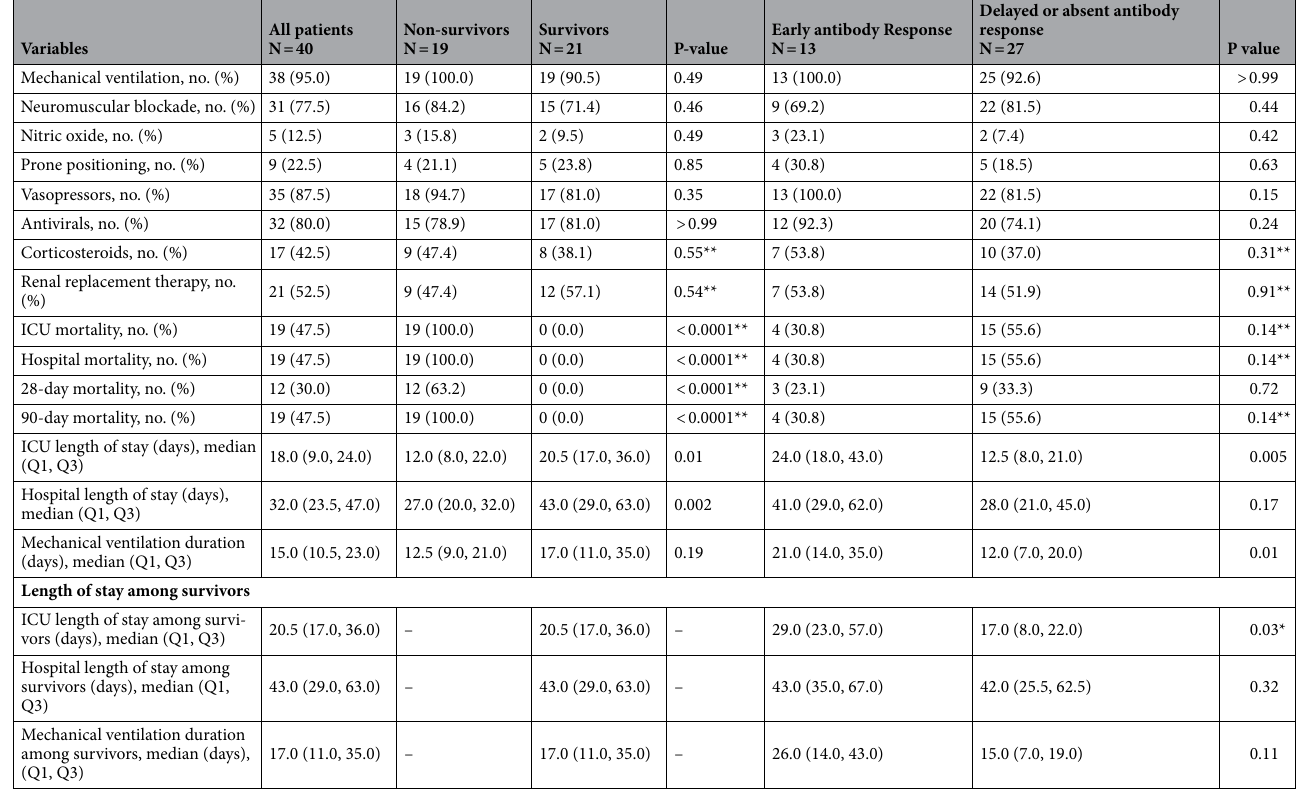
Table 2. Main interventions and outcomes of patients with Middle East respiratory syndrome (MERS) among non-survivors, survivors and those with early antibody response and delayed or absent antibody response. ICU: Intensive care unit; Q1: first quartile, Q3: third quartile. For all percentages, the denominator is the total number of subjects in the group. For continuous variables, Mann–Whitney U test is used to calculate the p-value except for p values labeled with * indicating the use of Students t test. For categorical variables, Fisher’s exact test is used to calculate thep-value except for p values labeled with **indicating the use of Chi-square test.